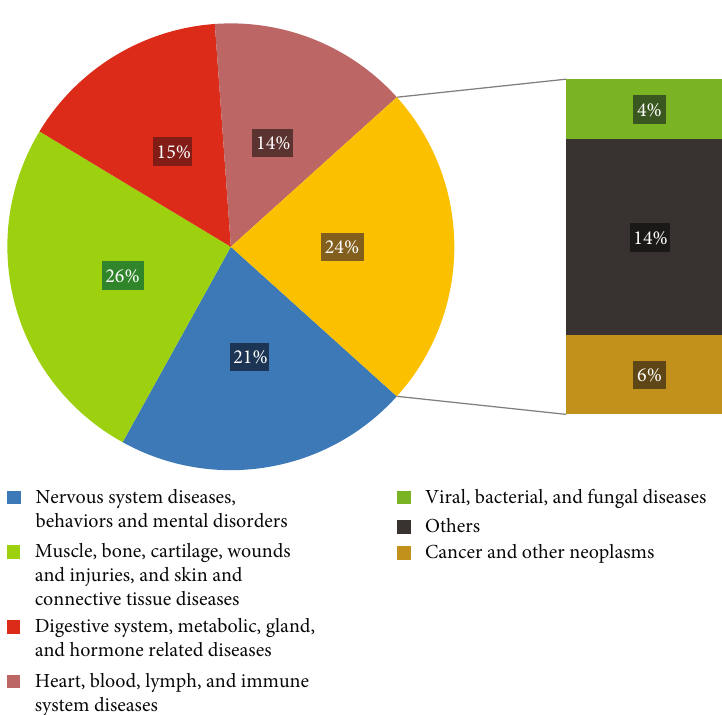
Figure 6: Category distribution and percentage of registered clinical